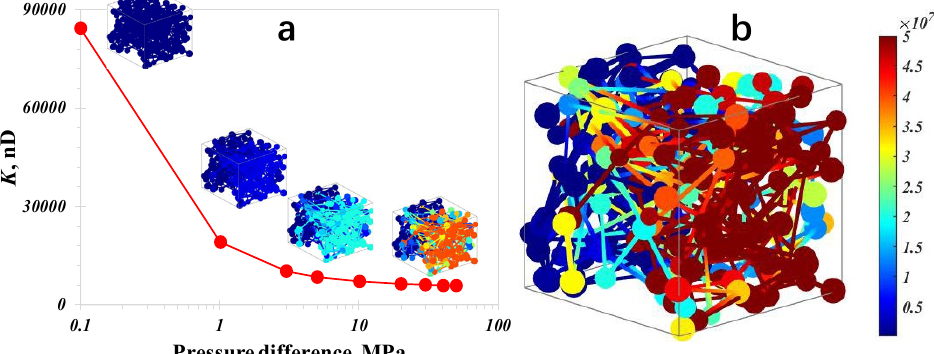
Figure 4. Apparent gas permeability under the displacement pressure-difference condition ( a ): Gas transport capacity; ( b ): Spatial pressure distribution feature.